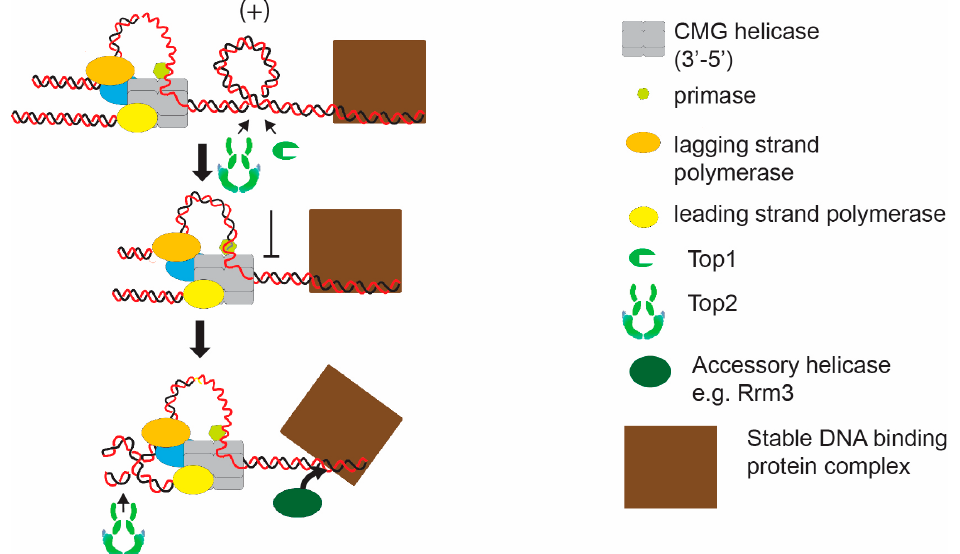
Figure 2. Hypothetical model of induction of topological stress at a stable protein ‐ DNA complex. As the replisome approaches a stable protein ‐ DNA complex, topoisomerases are inhibited from acting between the complex and the converging replisome. Potentially, this will initiate fork rotation to facilitate unwinding. In this case replication fork elongation will also be facilitated by the action of an accessory helicase, such as Rrm3, which will promote displacement of the stable protein ‐ DNA complex.